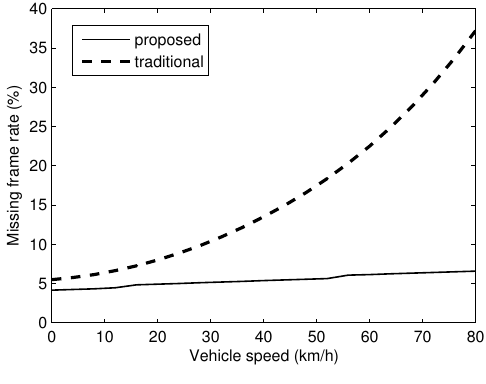
Figure 12. Tracking error rate over 100 images